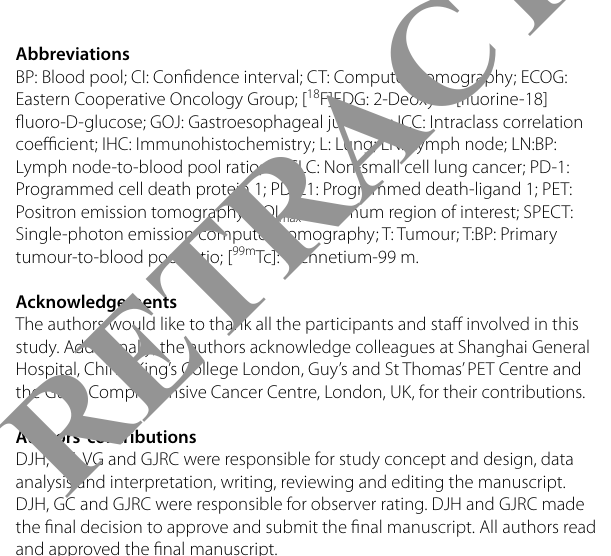
-0.04, p 0.462); c LN:BP scores observer B, time 1 versus time = = 0.09, p = =